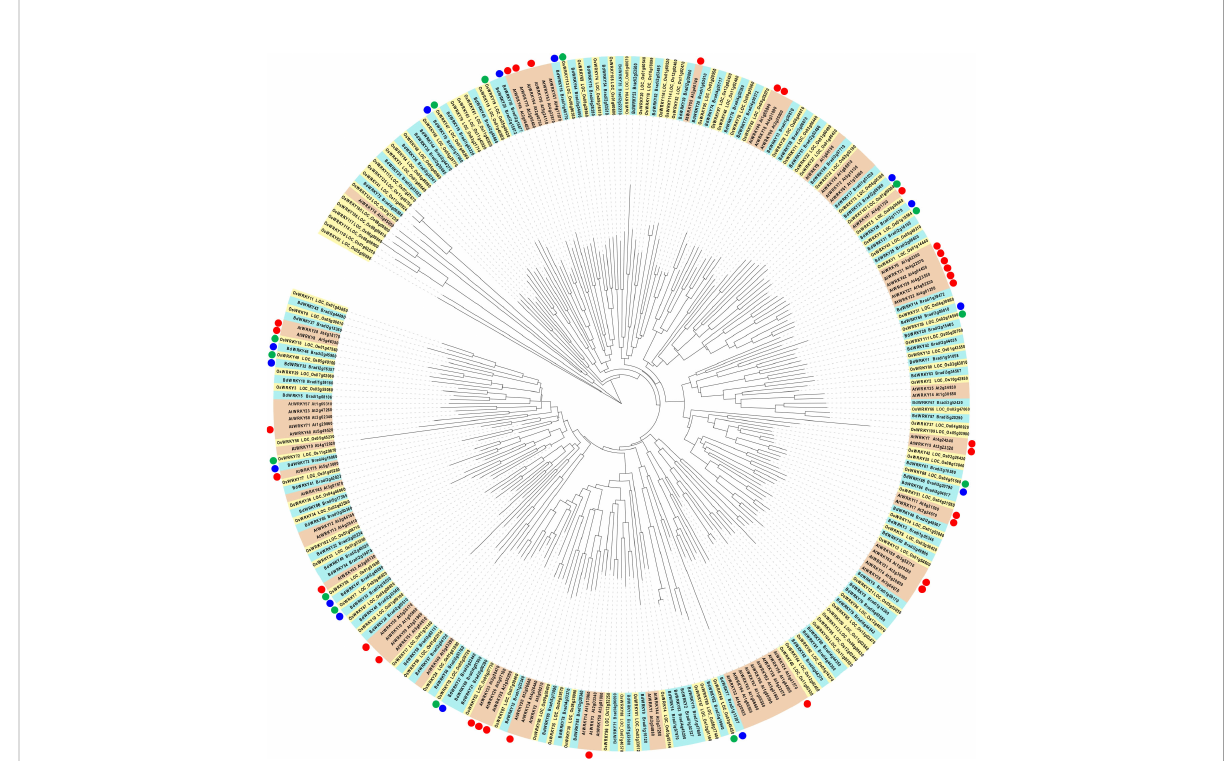
FIGURE 8 Phylogenetic analysis of WRKY proteins in Arabidopsis (red box), Brachypodium distachyon (blue box), and rice (yellow box), and their responsiveness to MAMPs. The nomenclatures of WRKY genes in Arabidopsis, rice, and ( B ) distachyon followed Eulgem et al. (2000); Rice WRKY Working Group (2012), and Kouzai et al. (2020), respectively. Arabidopsis WRKY genes, commonly induced at 30 min after the treatment of various MAMPs (Bjornson et al., 2021), are marked with red circles. Blue circles indicate ( B ) distachyon WRKY genes in clusters 5 and 6 (upregulated at 30 and 60 min after the fl g22 treatment, respectively). Green circles indicate the rice homologs of ( B ) distachyon WRKY genes marked with blue